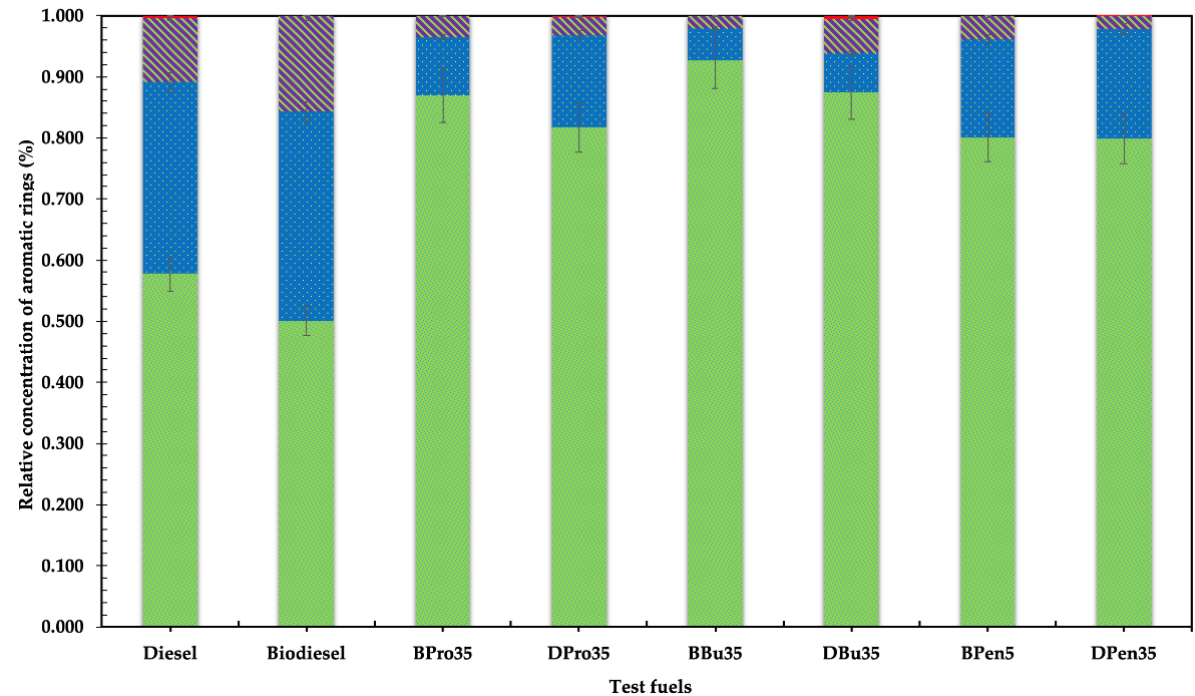
Figure 3. Relative Distribution of PAHs.